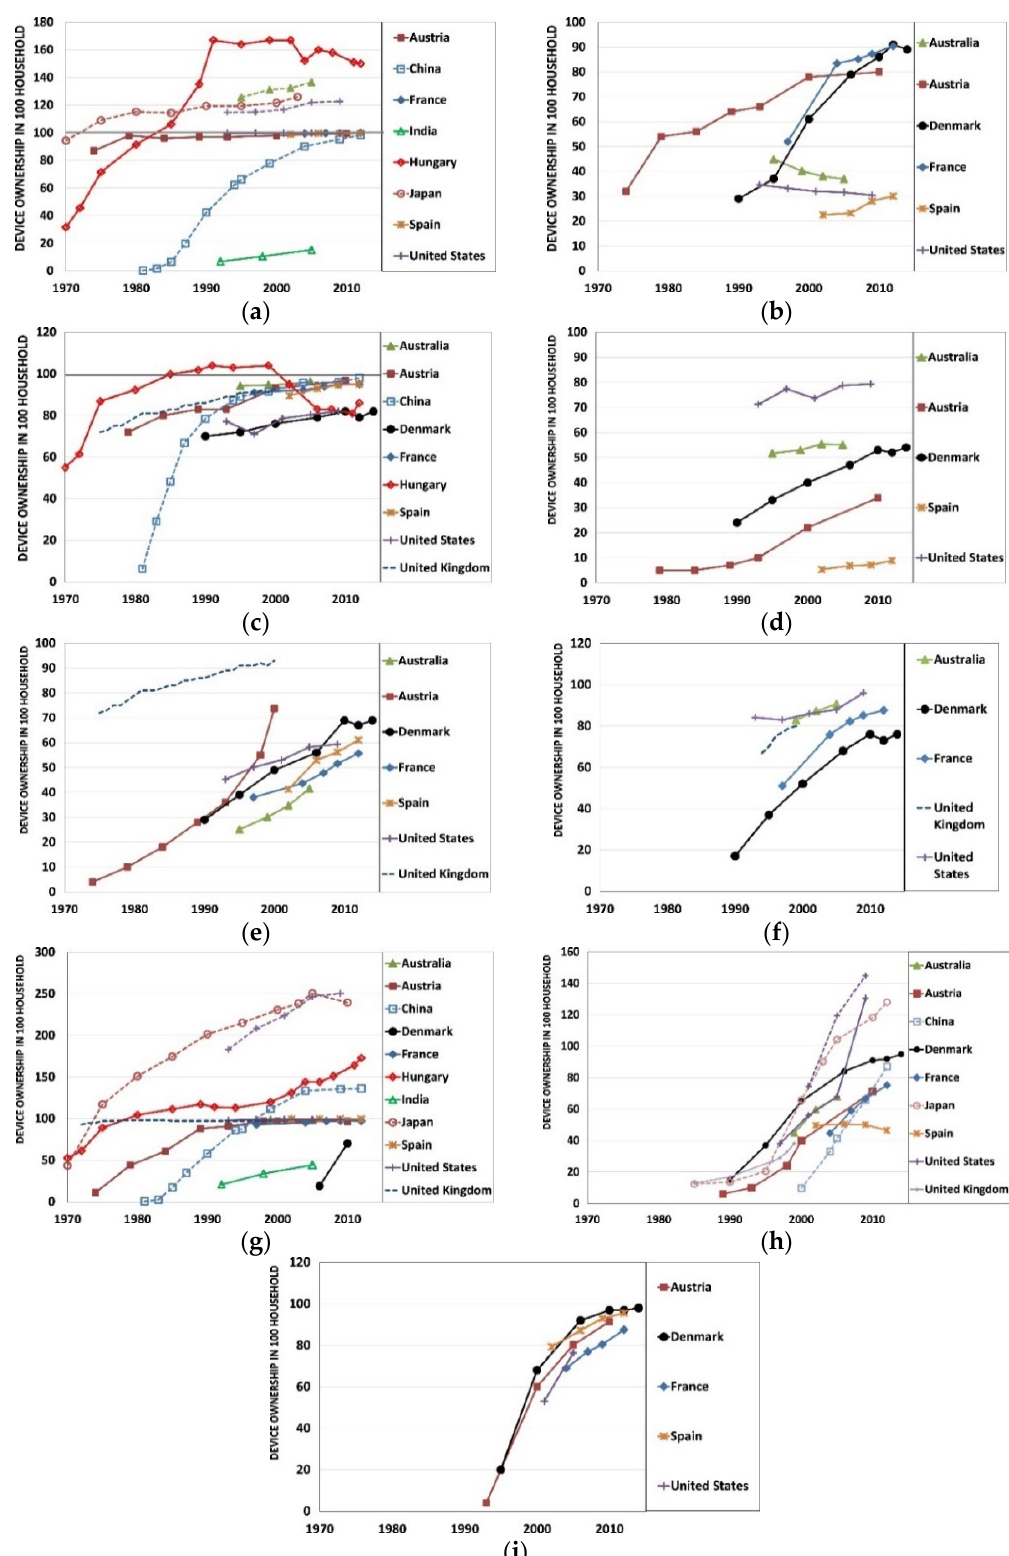
Figure 2. Appliances ownership. ( a ) Refrigerators; ( b ) freezers; ( c ) washing machines; ( d ) clothes dryers; ( e ) dishwashers; ( f ) microwave ovens; ( g ) televisions; ( h ) computers; ( i ) mobile phones. Reprinted with permission from Ref. [7]. Copyright 2018, Elsevier.